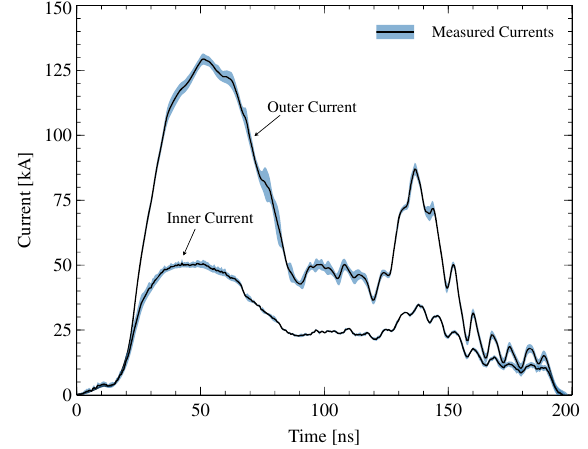
FIG. 2. Measured inner and outer currents from Mercury shot 2049, as measured 63 cm upstream of the anode. The solid lines are the mean values of the azimuthal current measurements, while the blue shaded regions show the uncertainty bound given by (cid:2) U m .